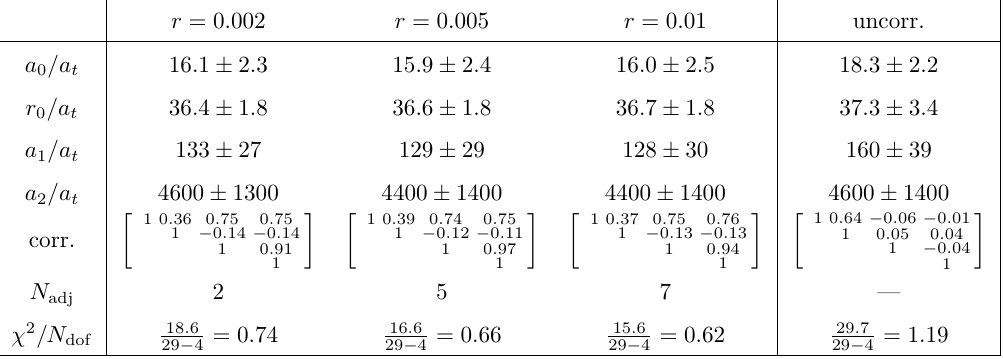
Table 12 . As table 11 but for D ¯ K I = 0 on the m π = 391 MeV ensembles, eq. (5.13).